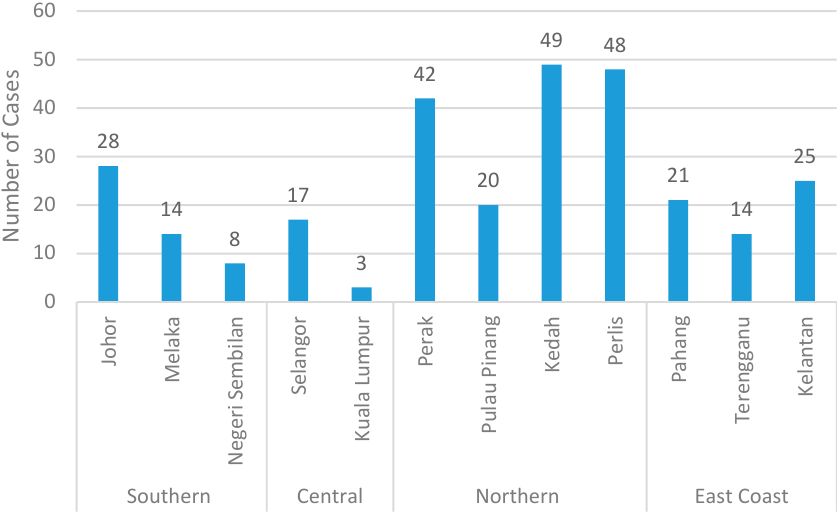
Figure 3. Windstorm damage cases from 2009 to 2016.